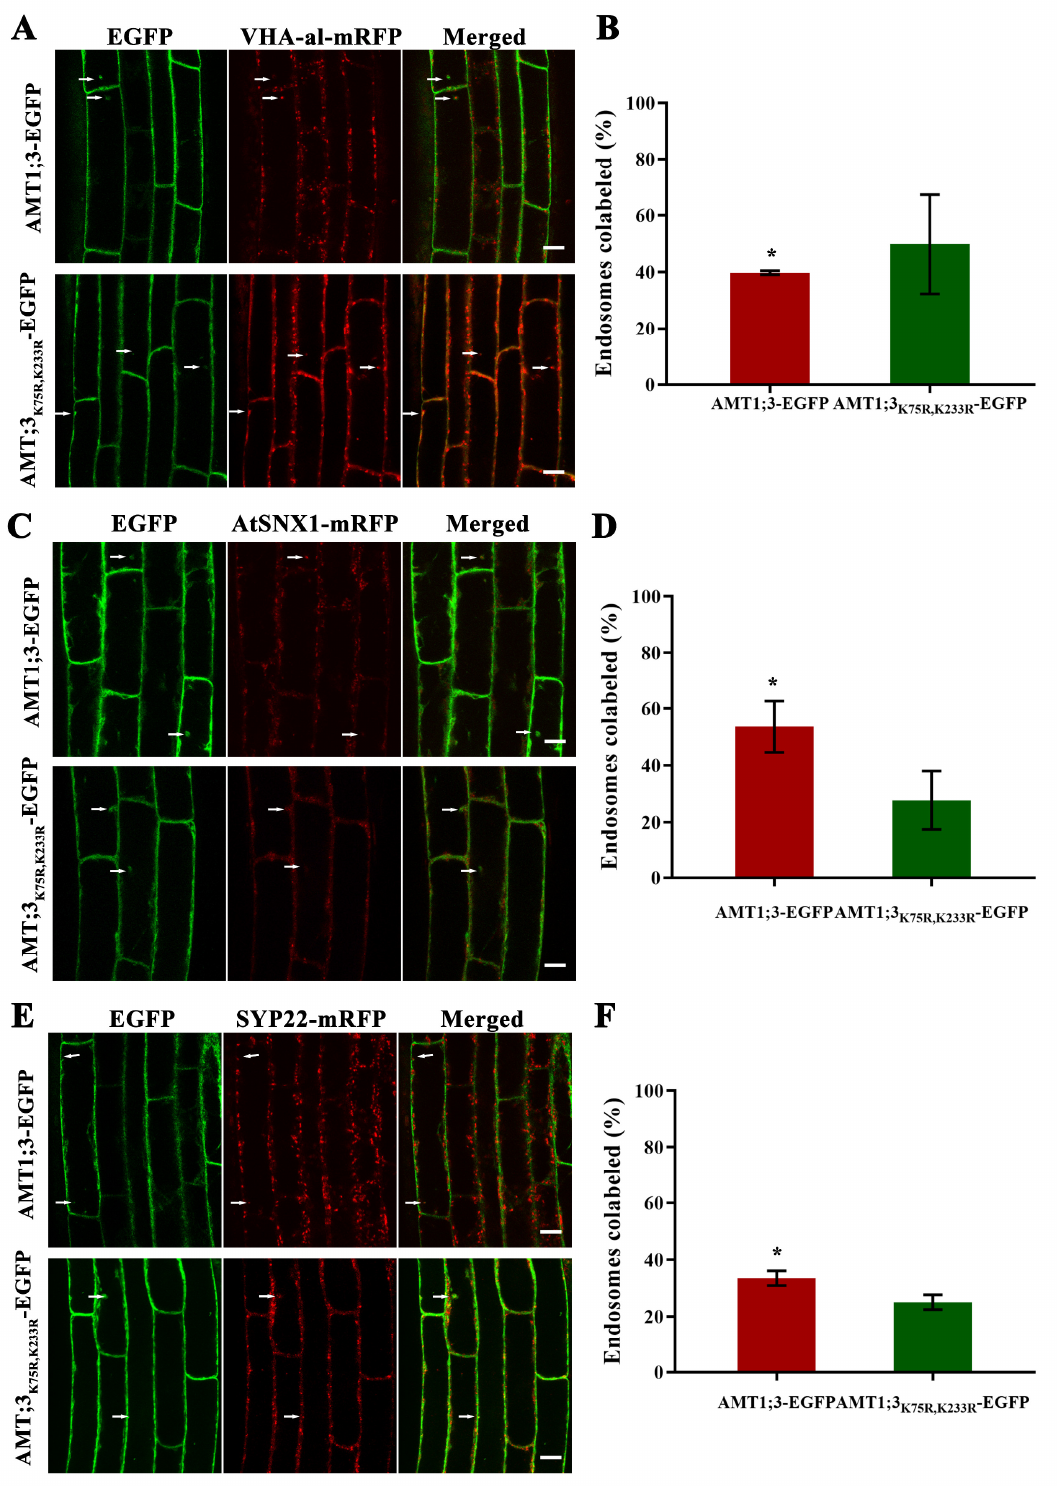
Figure 4. Ubiquitylation affects the colocalization of AMT1;3 with vesicle-transport-labeled proteins under high ammonium stress. ( A ) VHA-a1-mRFP endosomal markers partially colocalized with AMT1;3/AMT1;3 K75R,K233R -EGFP. Colocalizing endosomes are indicated by white arrows. AMT1;3/AMT1;3 K75R,K233R -EGFP is shown in green, VHA-a1-mRFP in red, and the merged image indicates colocalization (yellow). ( B ) Statistics of the colocalization of AMT1;3/AMT1;3 K75R,K233R -EGFP with VHA-a1 proteins. ( C ) AMT1;3/AMT1;3 K75R,K233R -EGFP partially colocalizes with late